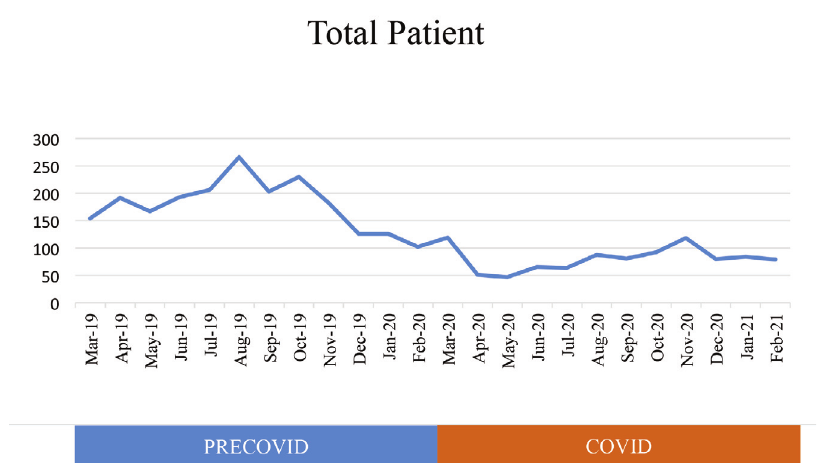
Fig. 1: Total Trauma of lower extremities patients of the Prof. Dr. R. Soeharso orthopaedic hospital.